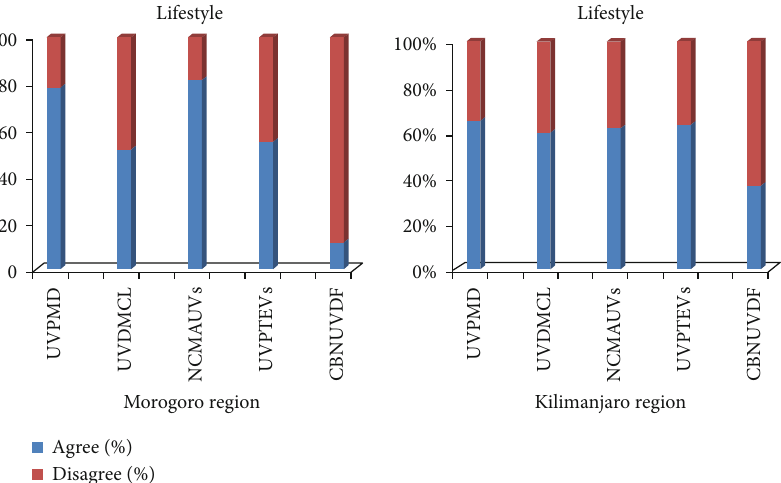
Figure 6: Lifestyle/image of consumers concerning UVs. UVPMD: UVs are considered as a “ poor man ’ s diet ” ; UVDMCL: UVs do not match consumers ’ lifestyle/image; NCMAUVs: nonconsumers have misconceptions about UVs; UVPTEVs: UVs are preferred to exotic vegetables; CBNUVDF: consumers have a basic need that UVs do not ful fi